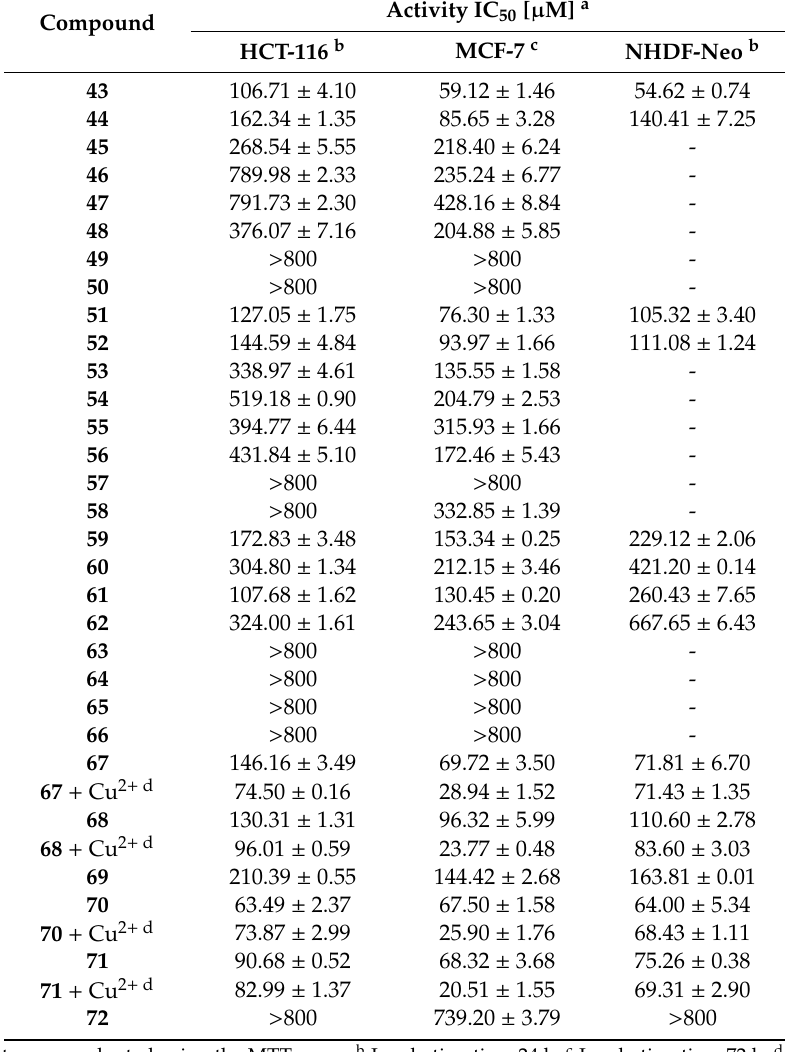
Table 2. Summary of cytotoxicity of tested glycoconjugates 43 – 72